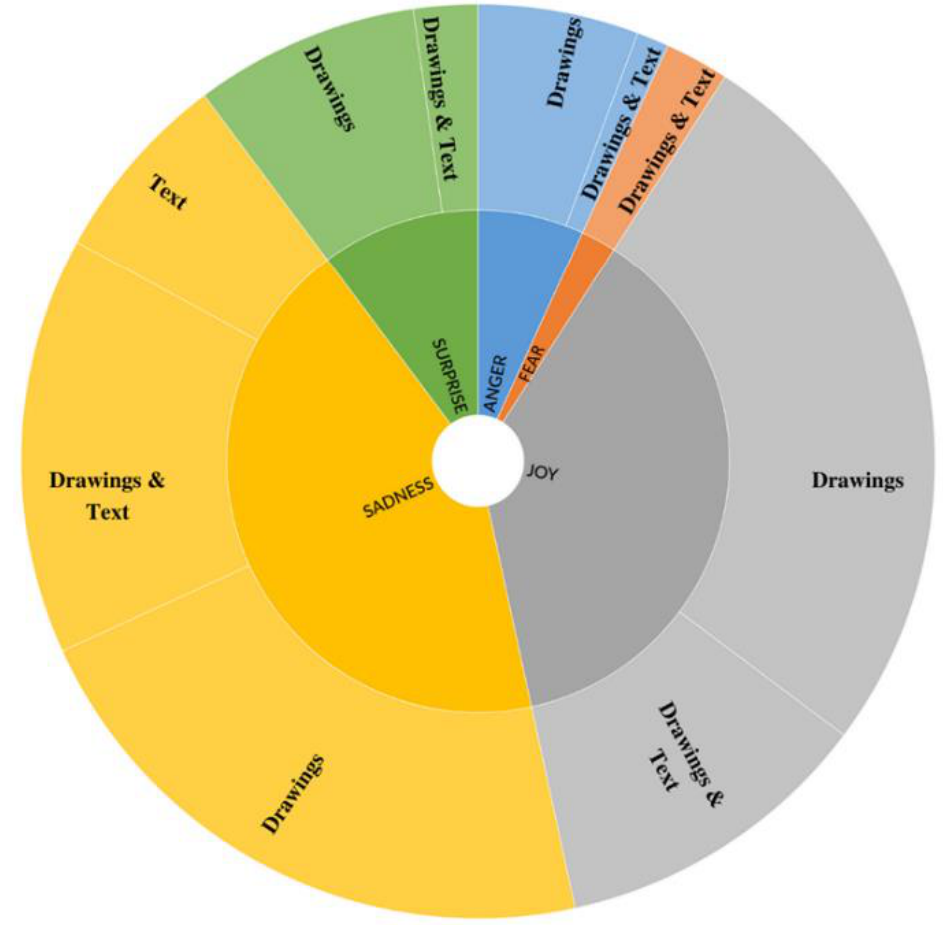
Figure 2. Emotions by visual and text representations. The innermost circle represents the emotions; the external circle is the visual representation for each emotion.